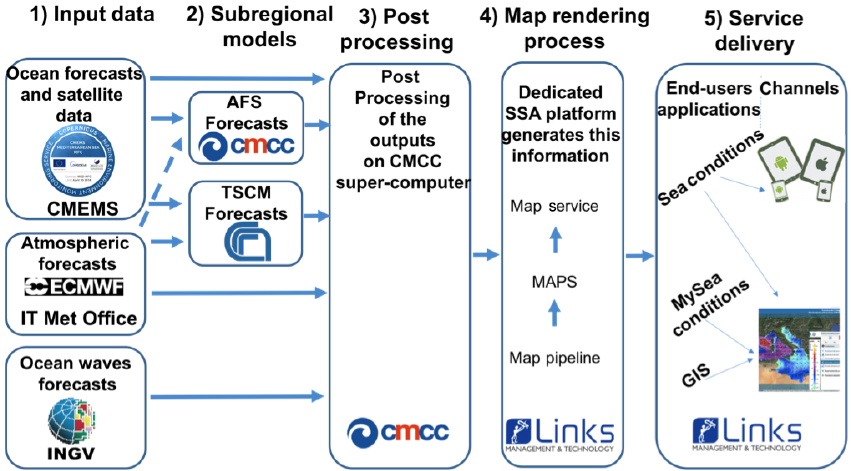
Figure 1. The SeaConditions operational chain: the external data providers ECMWF, CMEMS and INGV feed the data production and collection centres, where high spatial resolution ocean forecast models are run. The output fields are then sent to the SSA platform for map rendering before they are made available to the end-user applications, through both web and mobile channels. Table 1. Main characteristics of the forecasting systems used by